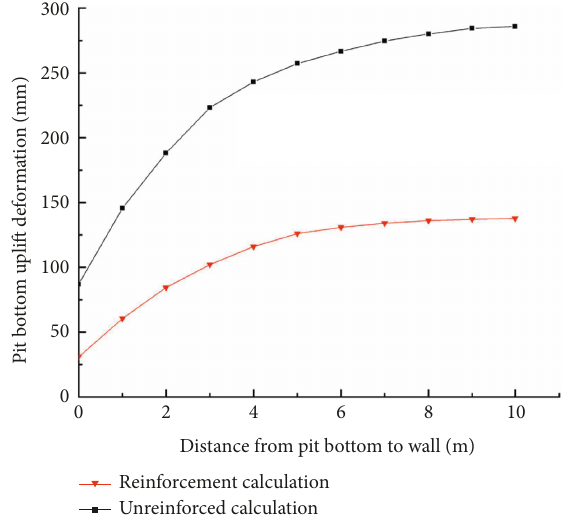
Figure 7: Calculated values of the foundation-pit rebound.